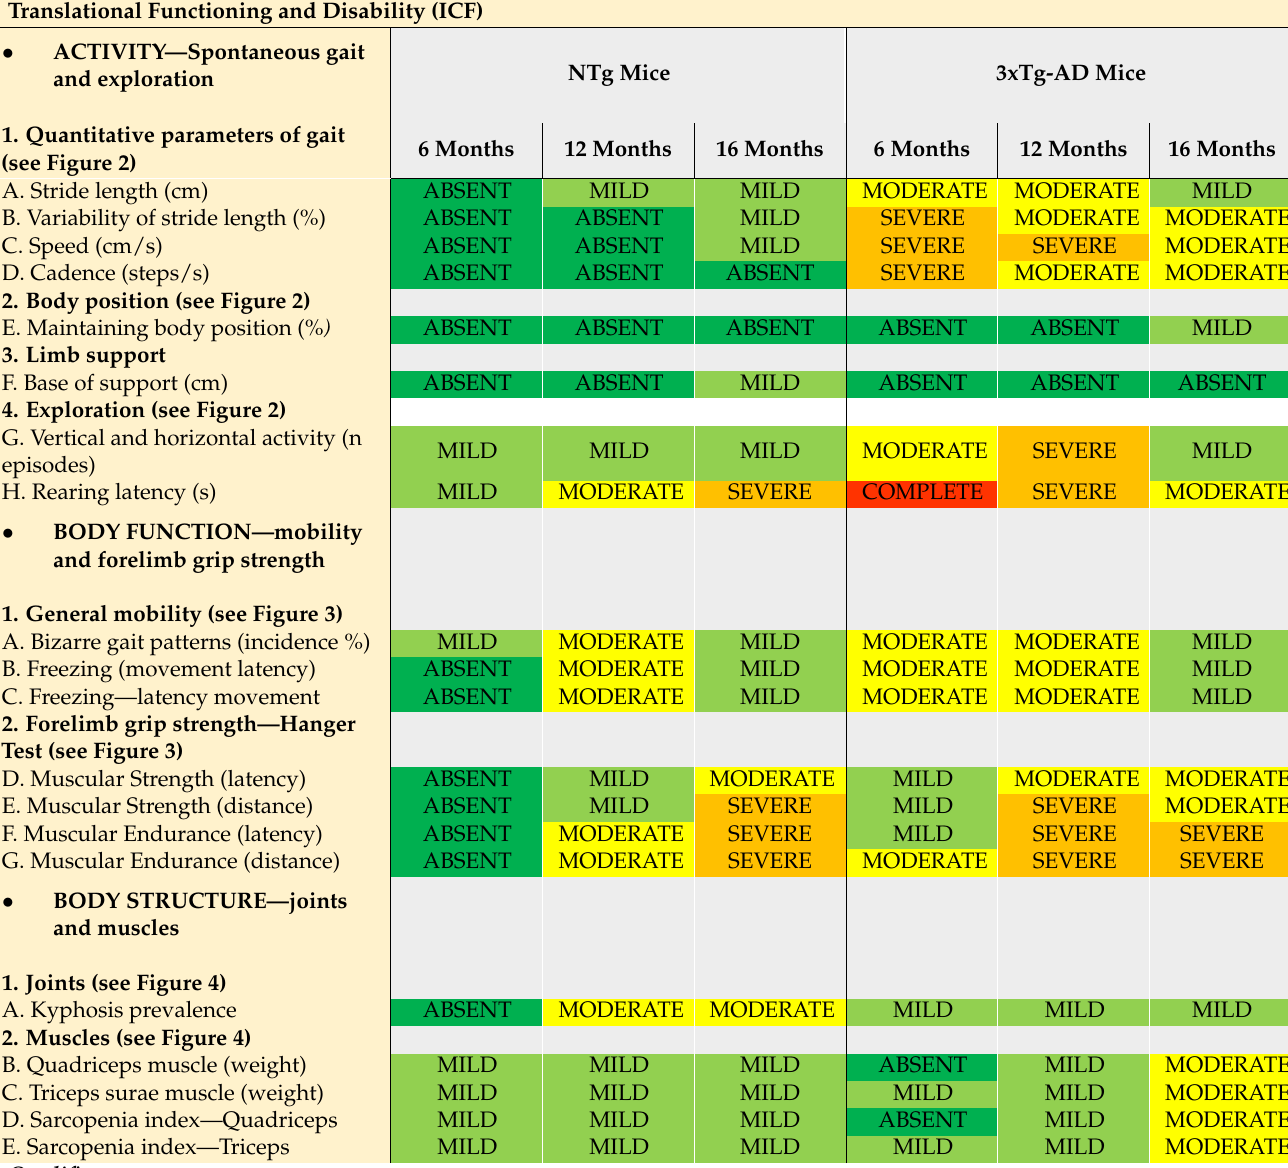
Table 1. Proposal to functional analysis to mimics capacities and disabilities from humans in mice.